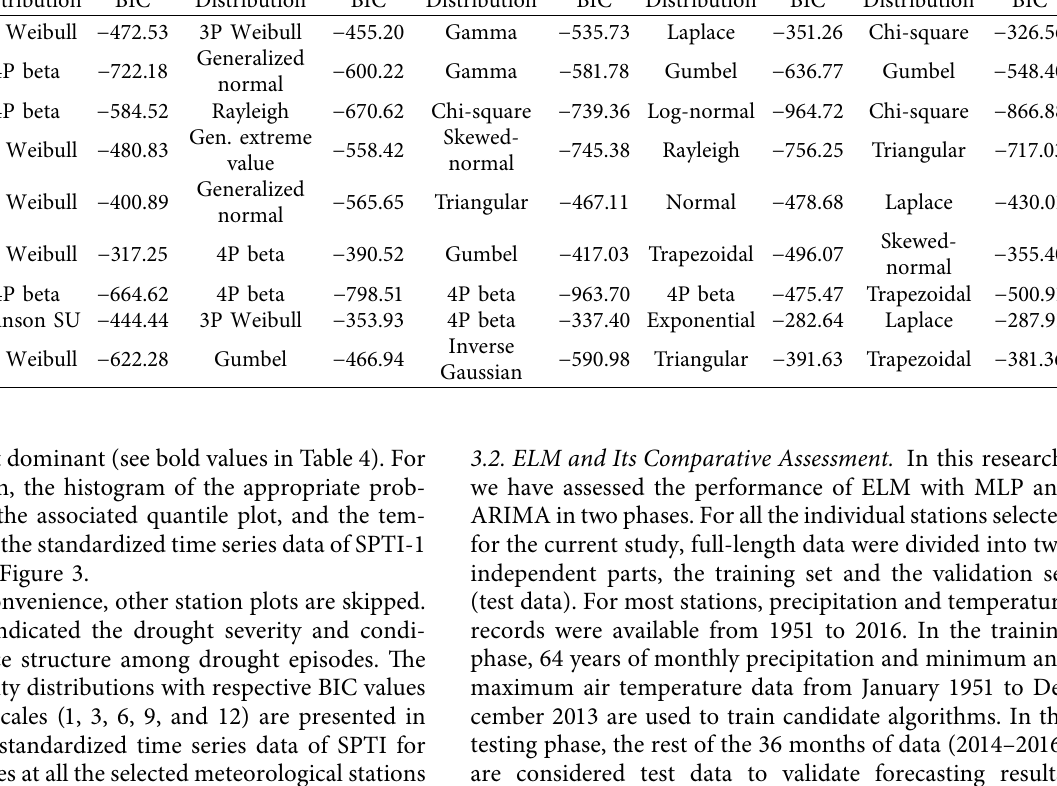
Table 5: Appropriate distributions with their respective BIC values for different time scales at nine meteorological stations. Stations